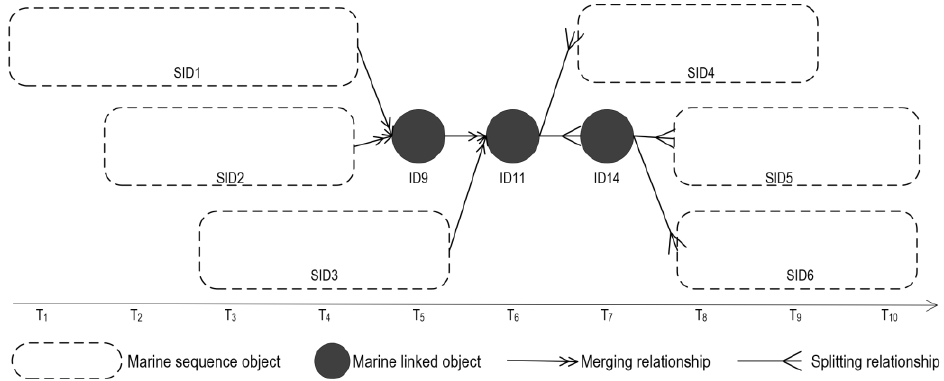
Figure 2. The evolutionary structure of a process object, which consists of six sequence objects, three linked objects, and their merging and splitting relationships. The evolutionary structure omits the snapshot objects and their evolutionary relationships.